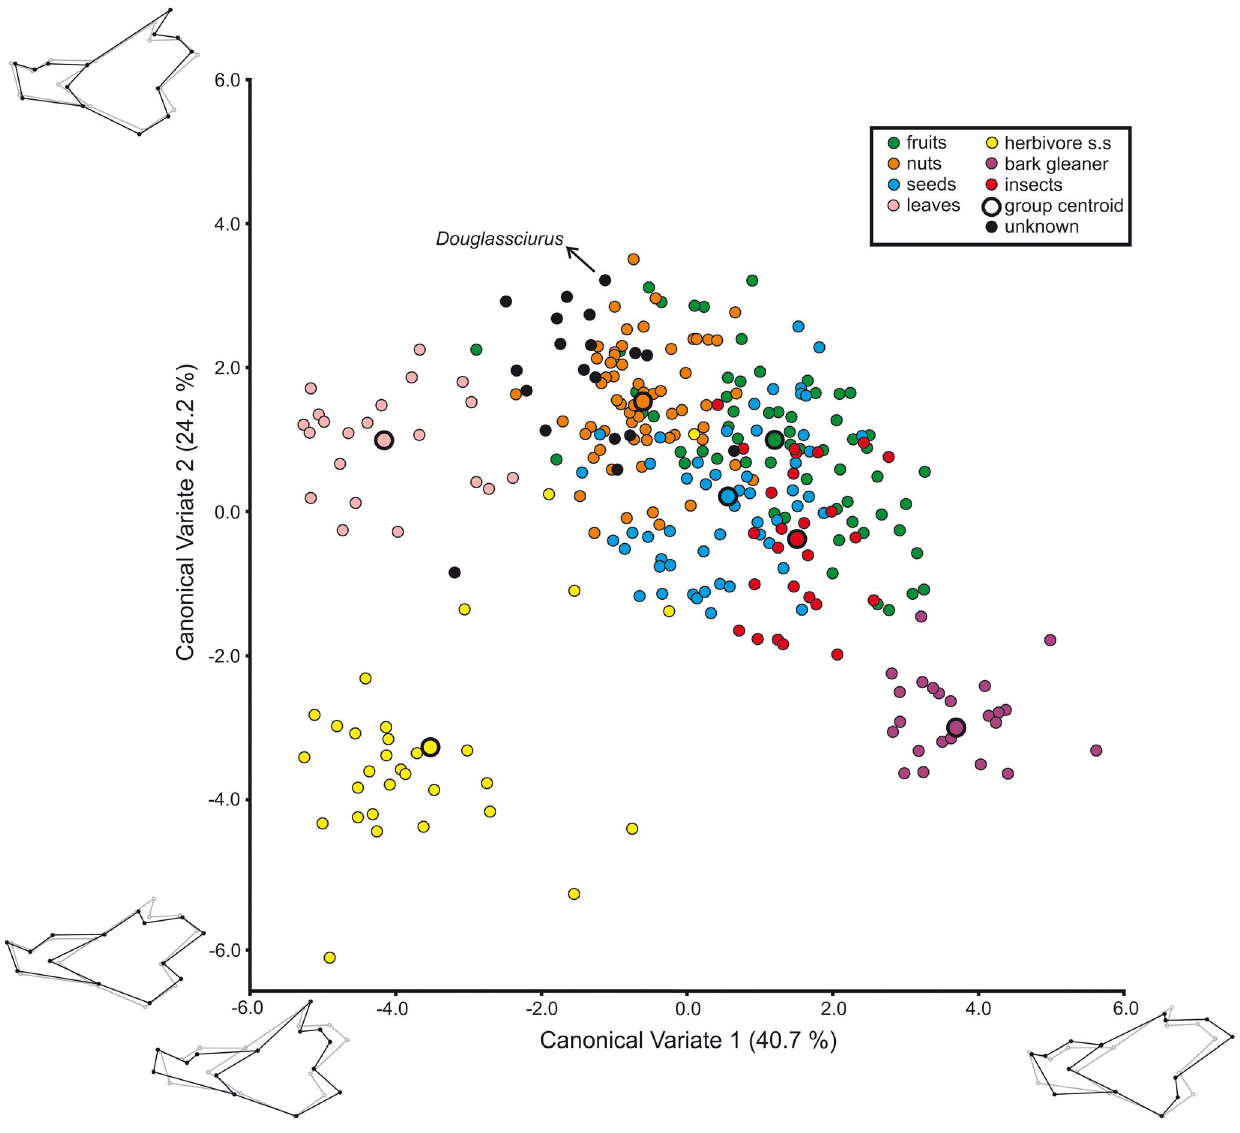
Figure 4. Canonical Variates Analysis (CVA) of squirrel mandible shape using dietary preferences as grouping variable. Plot of CV1 and CV2. For CV3 and CV4: see Figure S4. For a summary of classification results: see Table 3. For the results for each particular case: see Table S3.